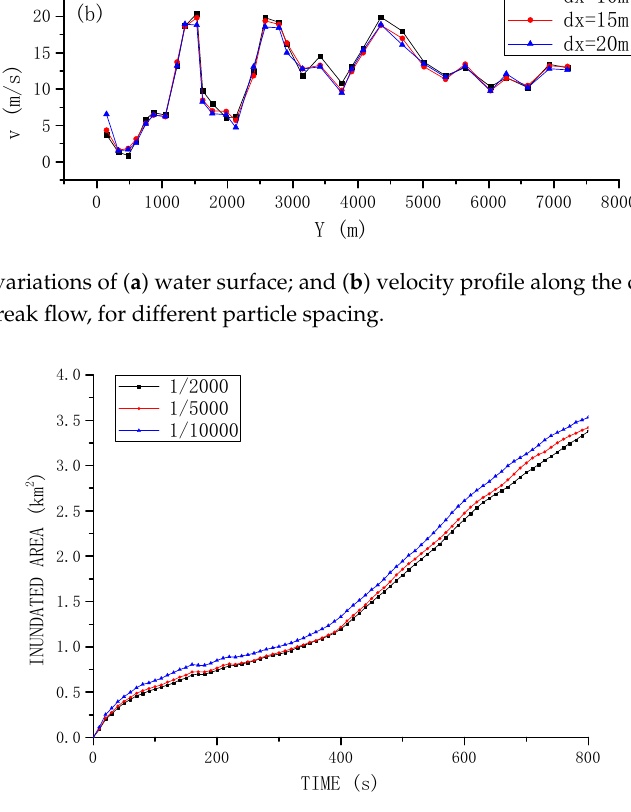
Figure 20. Downstream flooding area development for different flood frequencies.